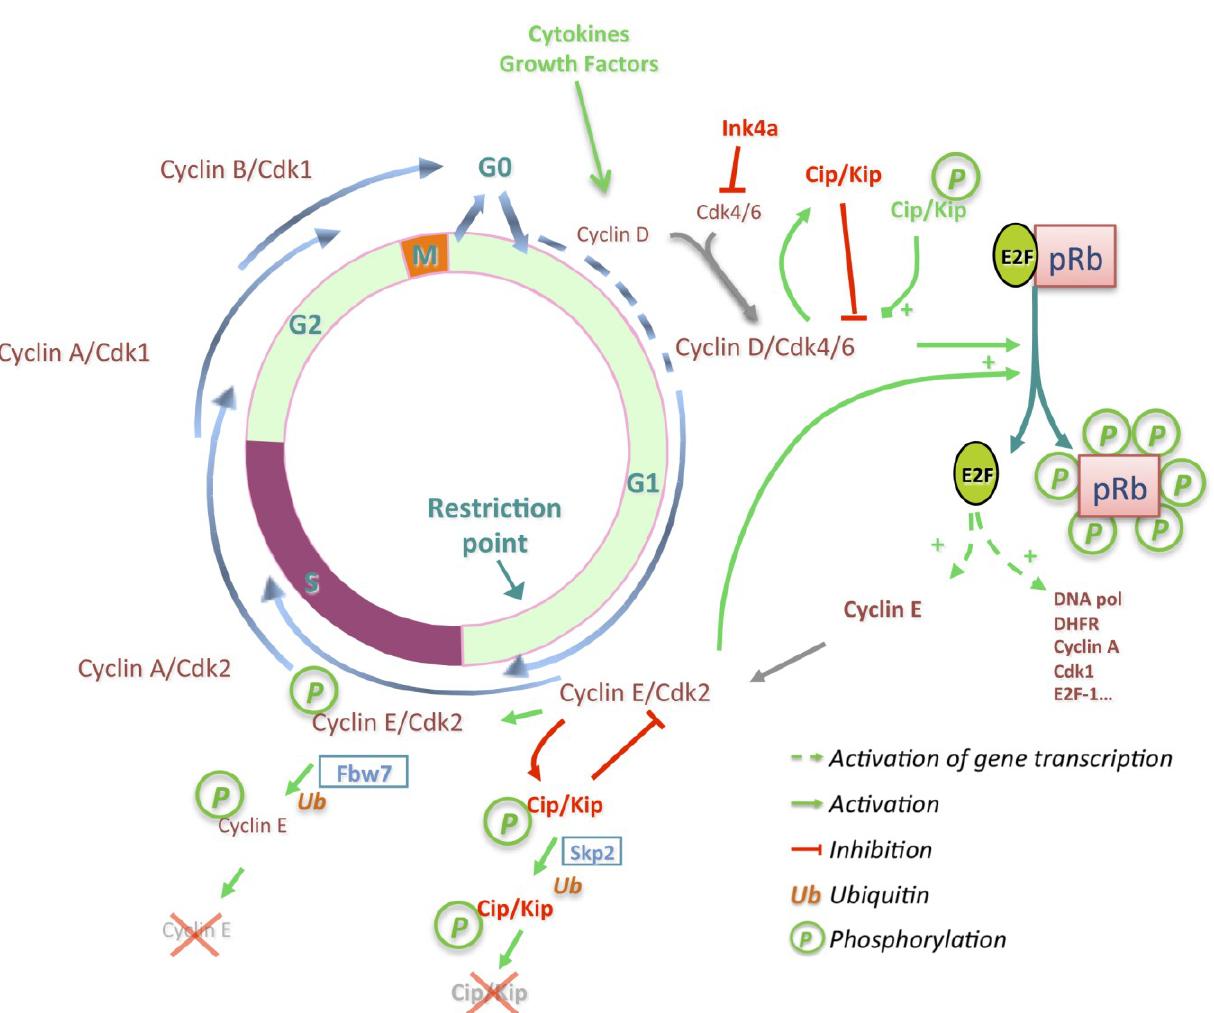
Figure 2. Progression through the different cell cycle phases is under the control of Cdk/cyclin complexes. Ink4 inhibitors impose a threshold on cyclin D expression to bind and activate Cdk4 in G1 phase. Newly formed Cdk4/cyclin D complexes are stabilized by Cip/Kip proteins and phosphorylate p21, changing its inhibitory to an activating state. Cdk4/cyclin D complexes initiate pRb phosphorylation, inducing the release from E2F1 transcription factors and promoting expression of genes implicated in the DNA synthesis phase and S phase progression. Cyclin E associates with Cdk2 enhancing pRb phosphorylation and phosphorylates Cip/Kip proteins leading to their ubiquitination and degradation. Successive association of Cdk2 with cyclin A, after the ubiquitination and degradation of cyclin E by Fbw7, leads to S phase completion and entry into G2 phase. Association of Cdk1 with cyclin A followed by cyclin B1 permits G2/M transition, entry in mitosis, and finally